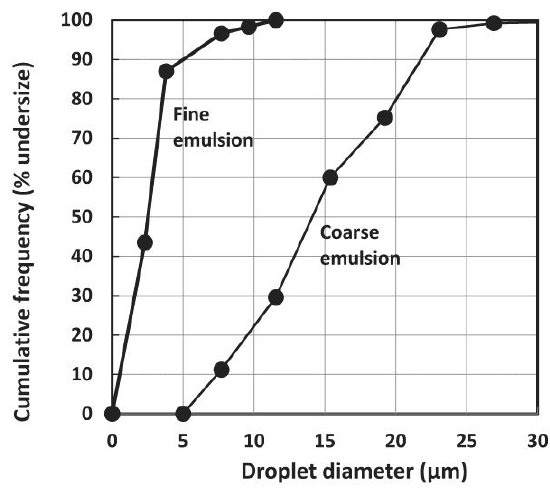
Figure 3. Comparison of droplet size distributions of fine and coarse O/W emulsions.